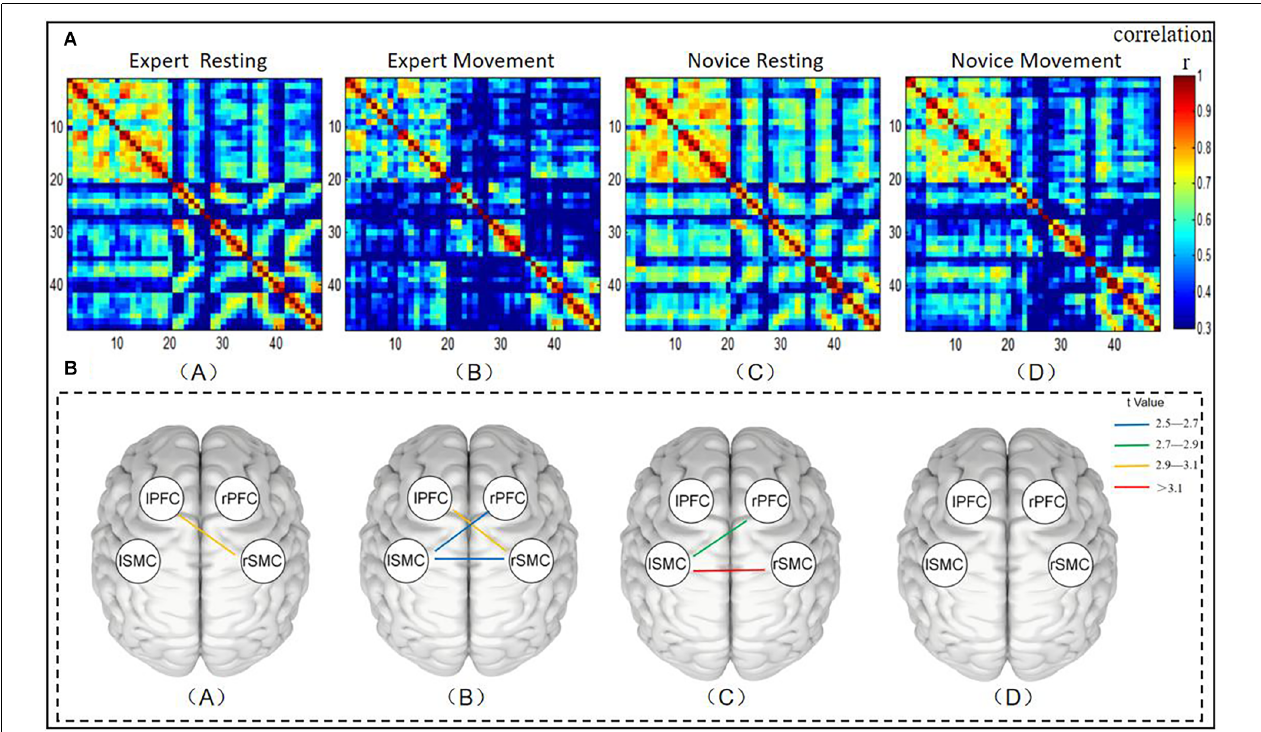
FIGURE 3 | (A) Diagram representing the functional connectivity between channels across brain regions. Panel (A) represents the functional connectivity strength of the expert group in its resting state. Panel (B) represents the functional connection strength under the operation of the expert group. Panel (C) indicates the functional connection strength of the novice group in the resting state. Panel (D) indicates the functional connection strength under the dynamic operation of the novice group. The two channels correspond to x- and y-coordinates. The pixel value represents the Pearson correlation coefficient of HbO between the two channels. The gradual change in the color bar from cool to warm colors indicates the change of the Pearson phase relation value, from small to large values. (B) Mapping of significant differences in functional connectivity between brain regions. (A) Brain regions with significant differences in functional connectivity between groups at rest. (B) Brain regions with significant differences in functional connectivity across exercise status groups. (C) Brain regions with significant differences between the expert group’s resting state and motility. (D) Brain regions with significant differences between resting state and exercise in the novice group. The color bar color changes from cold to warm colors reflect the t values changing from small to large